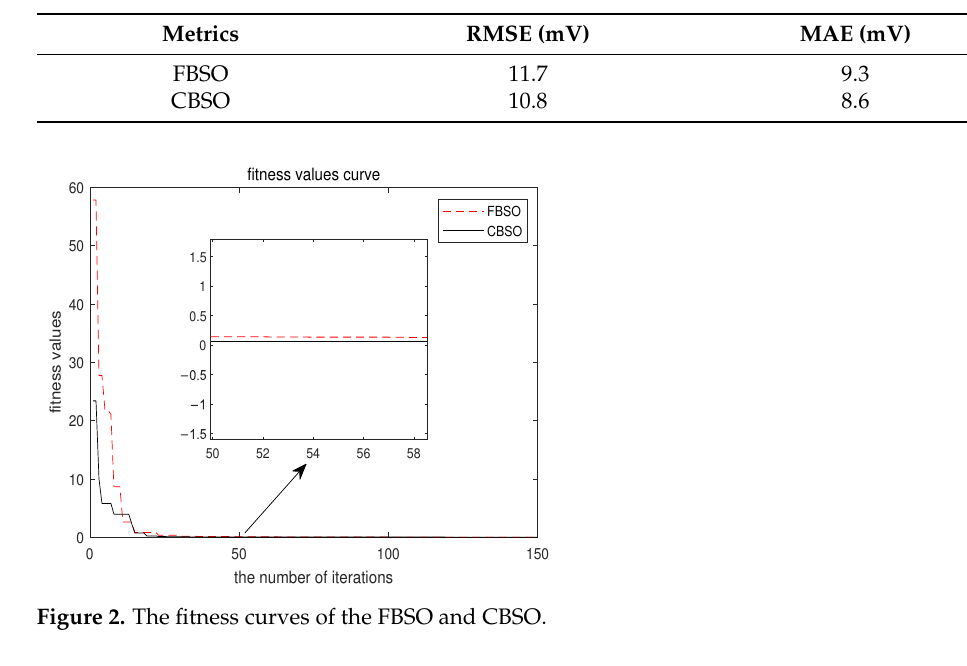
Table 3. The RMSE and MAE of the results of model parameter identification.